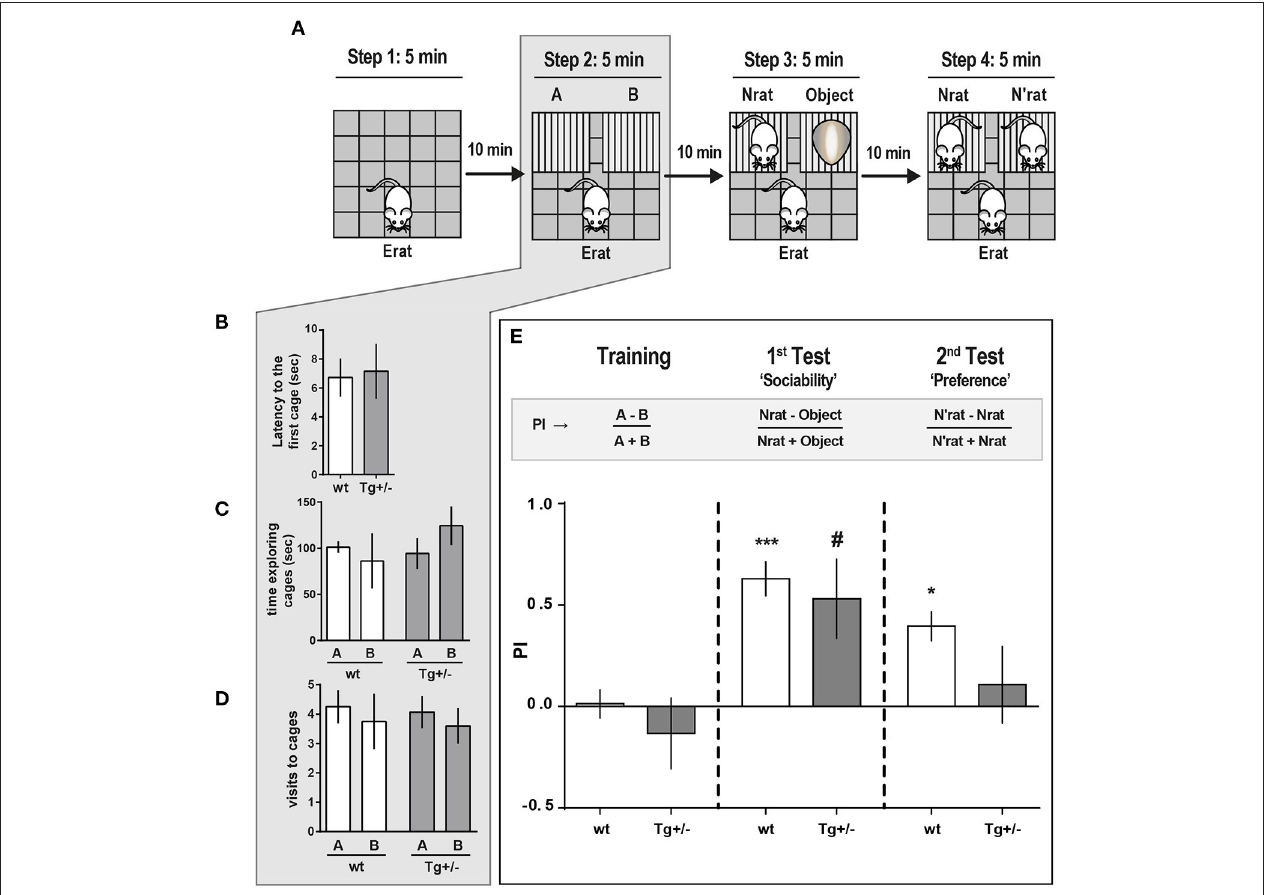
FIGURE 4 | Social approach behavior of McGill-R-Thy1-APP Tg + /– rats. (A) Schematic representation of the task steps. Tg + /– 4-month-old rats and their wt littermates were tested in an adapted social interaction-three chambered task. Step 1. Habituation: Erat was left to freely explore an OF for 5min. Step 2. “Training”: Exploration of the OF with two empty cages added. Erat was left to explore the same OF now containing cages A and B, for 5min, and the time Erat spent exploring each cage was recorded. Step 3. “Sociability”: An unknown novel rat (Nrat, same sex, and age as Erat) was placed inside one cage, and an unknown object (similar size and color as the Nrat) was placed in the other cage. The time Erat spent exploring either the Nrat or the object over 5min was recorded. Step 4. “Preference for Social Novelty”: 10min after Step 3, Erat was left to explore the OF with the already known Nrat in one cage and a novel N’rat (same sex and age of Nrat), in the other. Time Erat spent exploring either N or N’rat was recorded. (B) Latency to start exploring empty cages (A or B) (Step 2 of scheme in A) was similar for Tg + /– (dark gray bars, N Tg + / − = 12) and wt (white bars, N wt = 10) rats (bars represent mean latency ± SEM; Student t -test). (C) Time Erat spent exploring A or B empty cages. There were no significant differences between Tg + /– and wt rats (bars represent mean exploration time ± SEM; Paired t -test). (D) Number of visits either to A or B cages were not significantly different regardless the genotype (bars represent mean number of visits ± SEM; Paired t -test). (E) Preference Index (PI) for the three phases of the task: “Training” (control for location/cage (lack of) preference), “Sociability” and “Social Novelty.” “Training” (Step 2 of scheme in A). PI = A-B/A + B was not significantly different from zero for both genotypes, indicating that wt and Tg + /– Erats spent similar time exploring each cage, without any location/cage preference. 1st Test: “Sociability” (Step 3 of scheme in A). Both Tg + /– and wt Erats spent significantly more time exploring the Nrat than the object (’Sociability: PI Nrat − 0 bject = Nrat-Object/Nrat + Object > 0). 2nd Test: “Preference for Social Novelty” (Step 4 in A). Wt rats explored significantly longer time the N’rat than the Nrat (“Preference,” PI wt_N ′ rat − Nrat = N’rat-Nrat/N’rat + Nrat > 0), while Tg + /– rats spent similar time exploring the N’rat and the Nrat (“Preference,” PI Tg + / − _N ′ rat − Nrat ≈ 0). *** P < 0.001, * P < 0.05, # P < 0.05; One-way ANOVA, Dunnett post-hoc